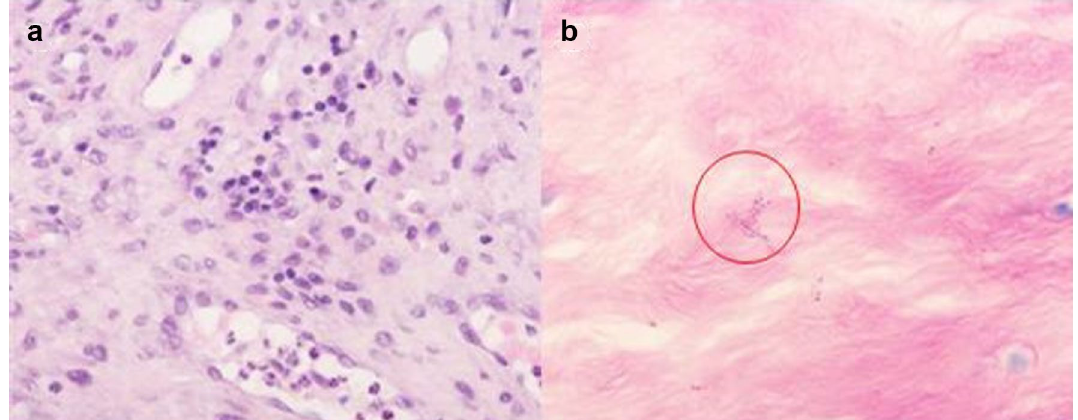
Figure 3. Histopathological results of postoperative lesions. ( a ) HE staining showed many different types of inflammatory cells in the lesions (× 400). ( b ) Brucella saw by Giemsa staining (× 1000).